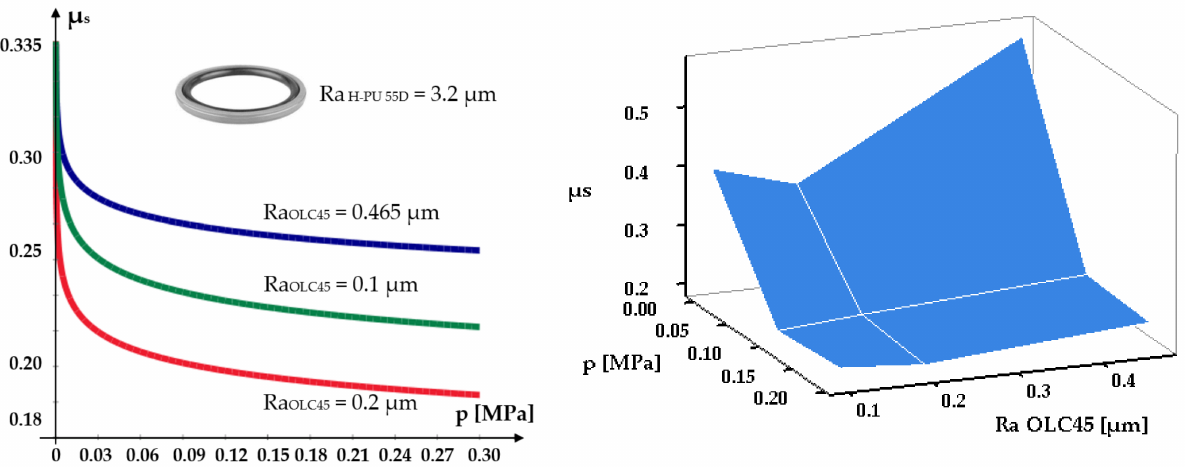
Figure 6. Dependency of the static friction coefficient on contact pressure and surface roughness for the material pair OLC45/H-PU